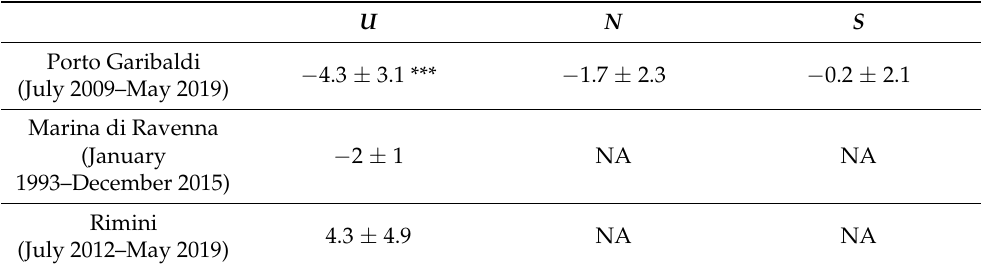
Figure 6. The comparison of observed (black) data (from GNSS, SA e TG) and those computed, i.e., indirectly derived from direct observations (green) at the Porto Garibaldi site. Associated linear trends are represented by dotted lines with the same color code of the time series. Table 5. U , N and S resulting from the SLE (Equation (1)) where N is the ASL variation, U is vertical displacement and S is the RSL variation (values in mm/year). NA = not available. The significance of the resulting trend varies according to the symbol beside each rate (significance code: *** p < 0.001). U